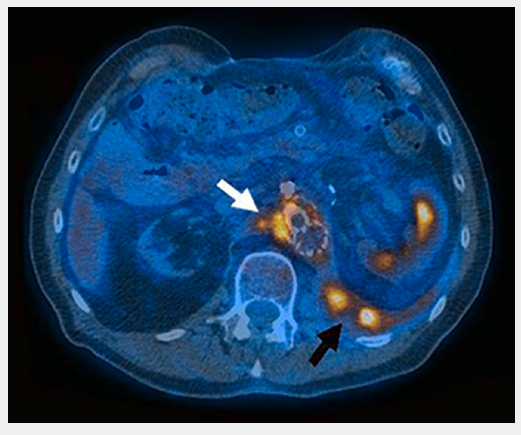
FDG-PET: Distinct, focal metabolic activity (SUV 11.8) adjacent to the Y- and renovisceral grafts (white arrow) with a spatial extension to an abscess in the left psoas region (black